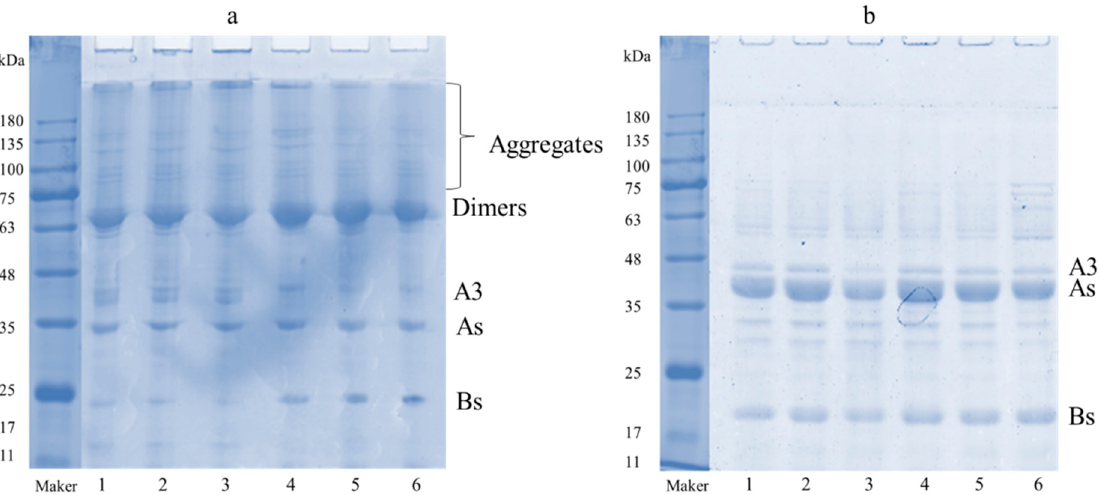
Figure 1. Non-reductive SDS-PAGE electrophoresis profile ( a ): 1–6 without 2-mercaptoethanol (2-ME) and SDS-PAGE electrophoresis profile ( b ): 1–6 with 2-ME. 1-Control, 2–50 °C, 3–60 °C, 4-Ultrasound, 5-Ultrasound-50 °C, 6-Ultrasound-60 °C.